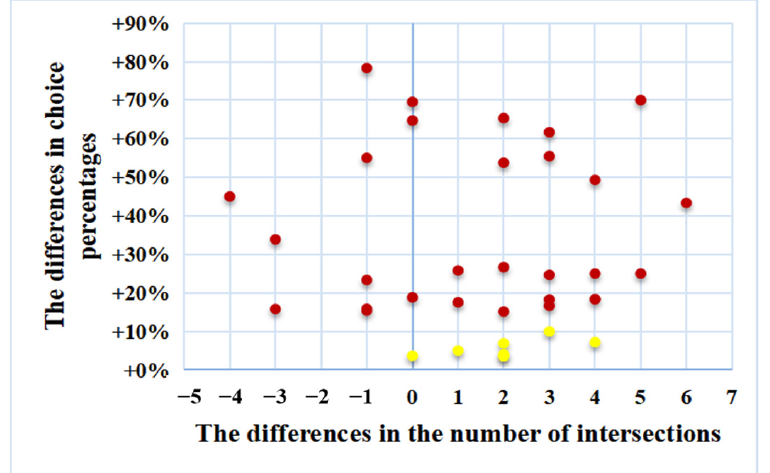
Figure 8. Differences in the choice percentages of the recommended routes with a different number of intersections.